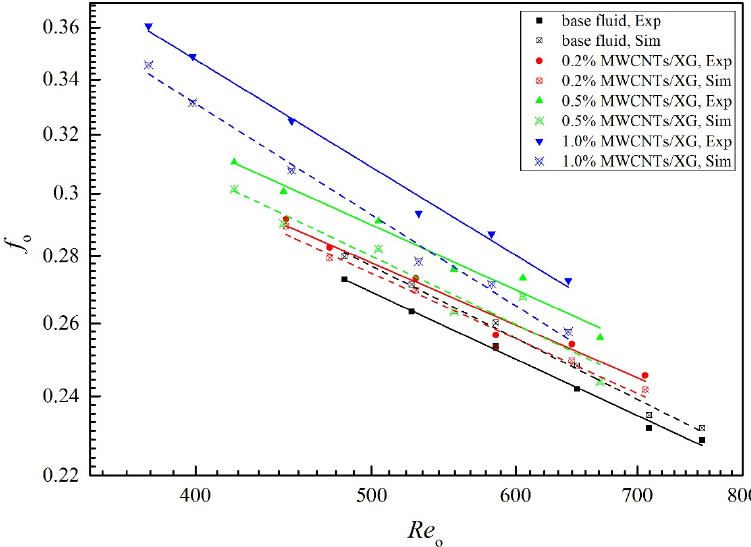
Figure 10. Friction factor based on experiment and simulation versus shell ‐ side Reynolds number.